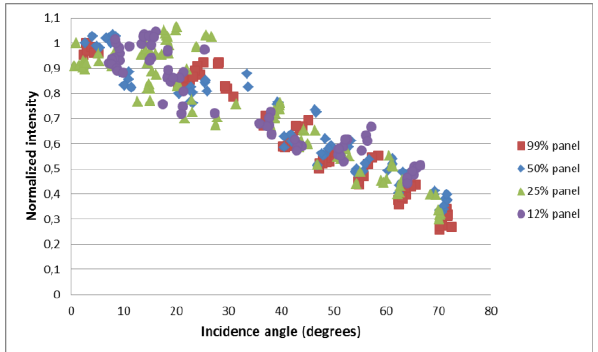
Figure 5. The 4-step Spectralon scanned from 1 m distance with incident angles ranging from 0 ⁰ to 82 ⁰ . The intensity is normalized to 1 at 0 ⁰